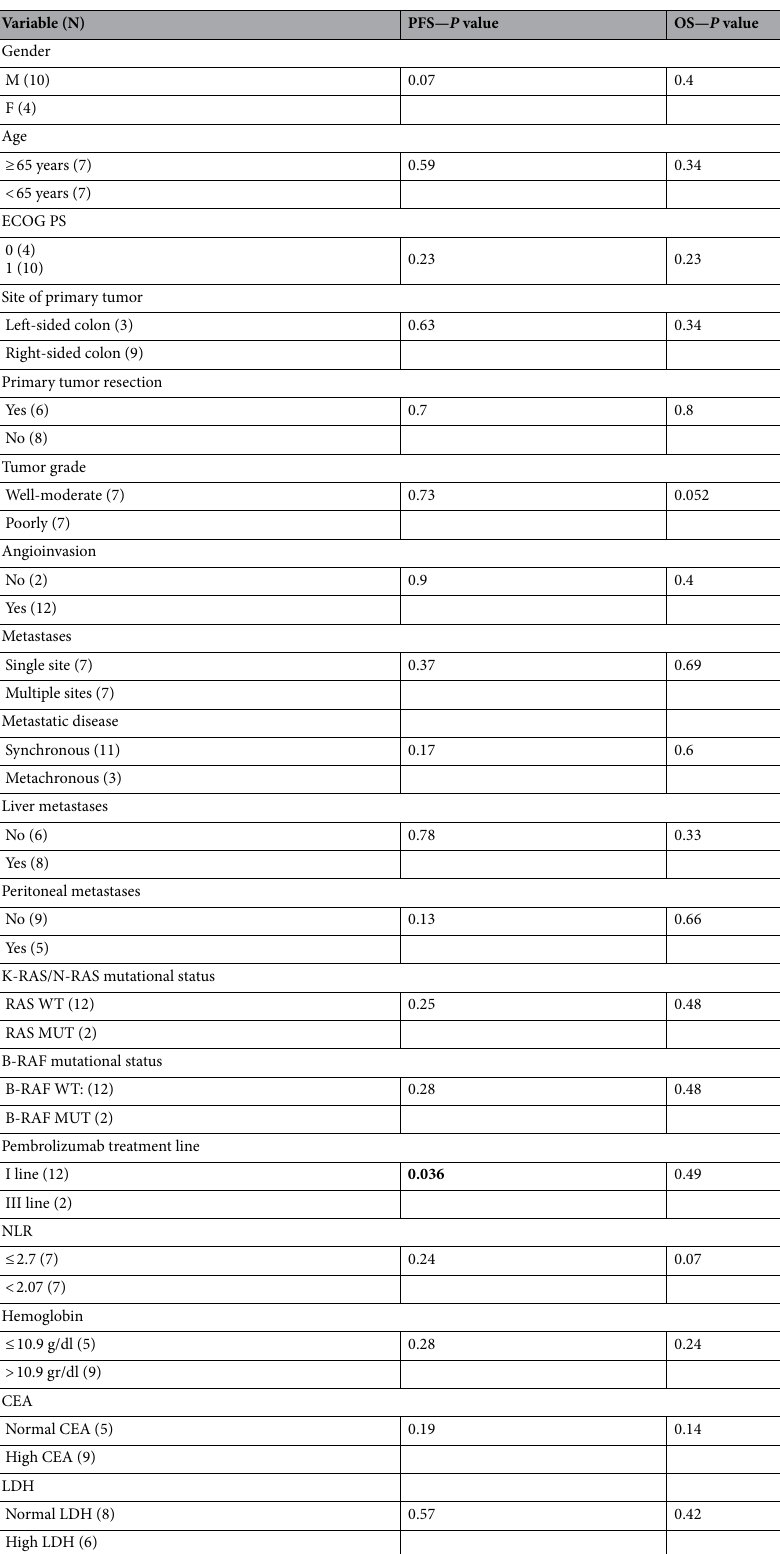
Table 3. Variable correlation with overall survival and progression free survival at univariate analysis. N: number of patients; PFS: Progression Free Survival; OS: Overall Survival; K-RAS: Kirsten rat sarcoma virus; N-RAS: neuroblastoma ras viral oncogene homolog; B-RAF: v-Raf murine sarcoma viral oncogene homolog B; ECOG PS: Eastern Cooperative Oncology Group Performance Status; WT: wild type, MUT: mutated; NLR: Neutrophil to Lymphocyte Ratio; LDH: lactate